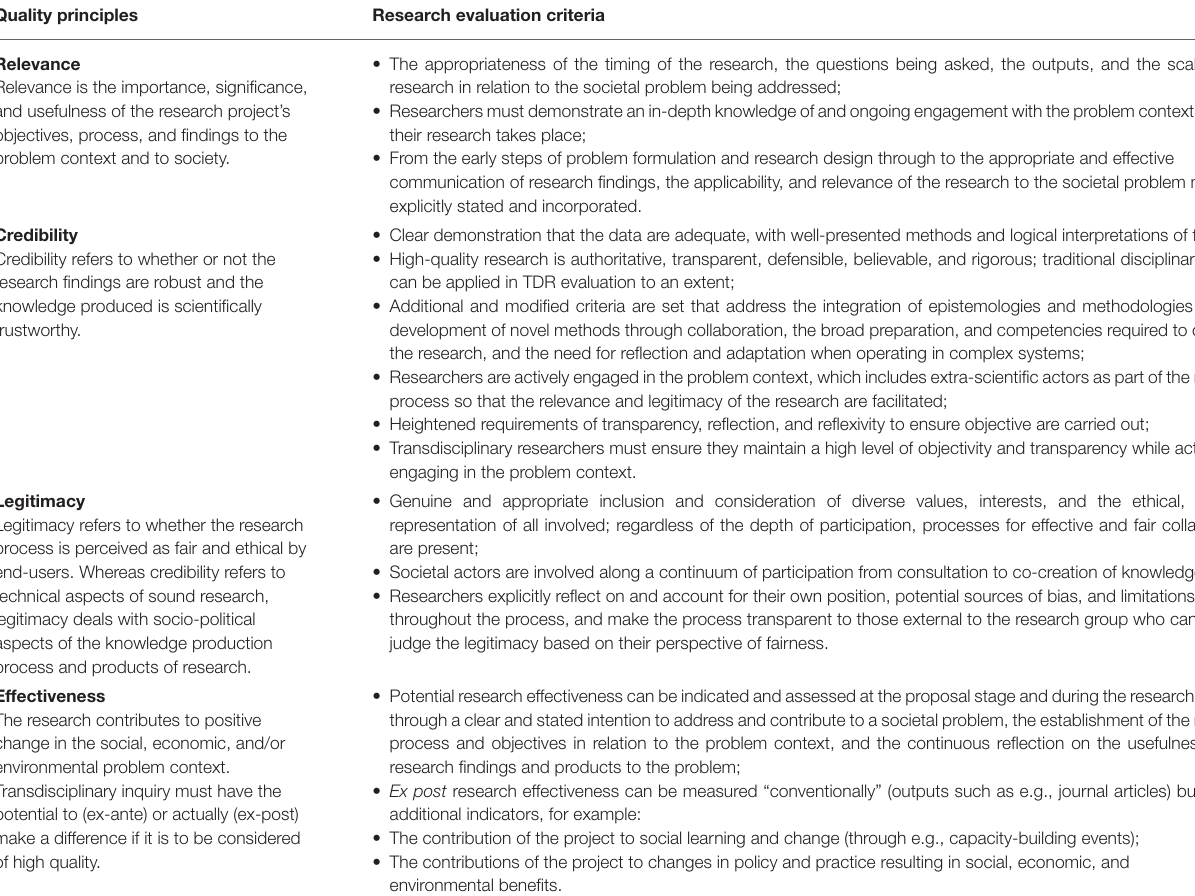
TABLE 2 | Transdisciplinary research quality criteria (adapted from Belcher et al., 2016; in Basta and Kunseler, 2018). Quality